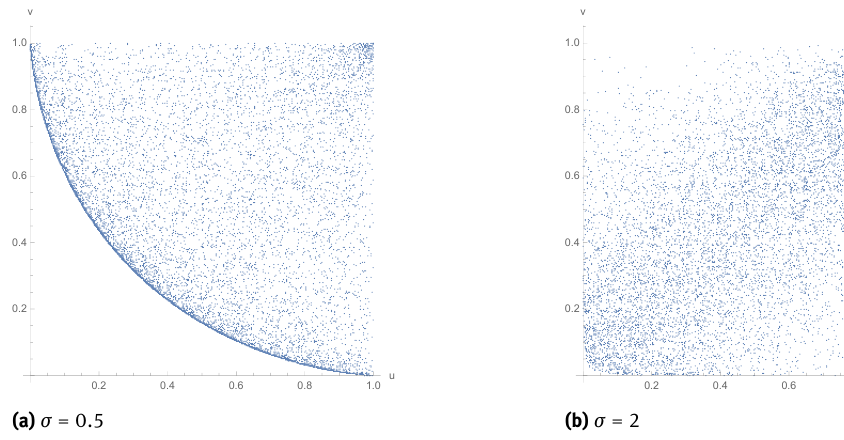
Figure 3: Two simulations from a lognormal Lorenz copula for different σ .